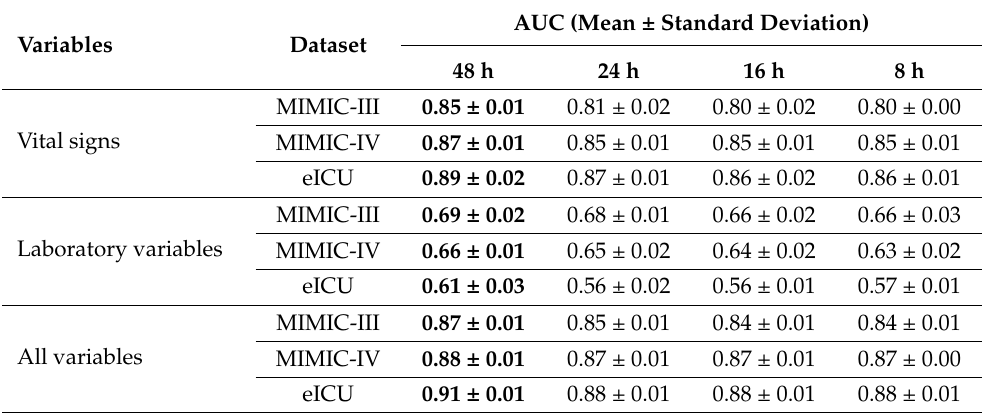
Table 5. Performance of the GRU model with different observation windows (T O =